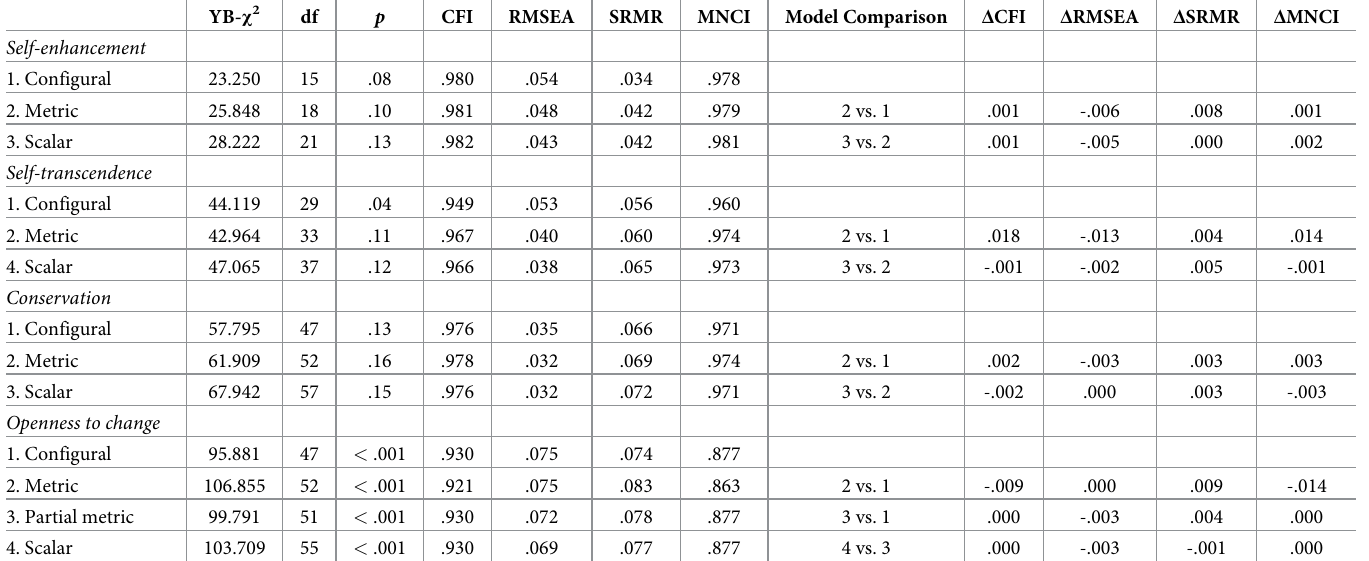
Table 2. Tests of measurement invariance across